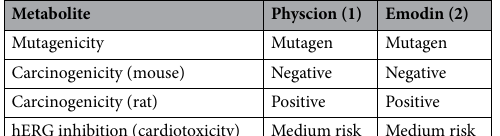
Molecular identification and phylogenetic analysis. All isolated fungal strains were taxonomically characterized by the extraction of their genomic DNA materials followed by PCR amplification and sequenc- ing of the fungal internal transcribed spacer (ITS) region using the universal primers ITS1 and ITS4 14,15 . The Blast tool in National Center for Biotechnology Information (NCBI) was used to compare the good quality sequences to the GenBank database to identify the closest related species with highly similar sequences to the amplified ones. Finally, the multiple sequence alignment and phylogenetic analysis were accomplished using MEGA7 software 22 . Fermentation and preparation of extracts. The pure isolated fungal endophytes were fermented in 1.5 L malt extract liquid medium by placing 2 × 2 cm segments of fresh growing agar culture using 5 L Erlenmeyer flasks. The flasks were incubated at 20 °C ± 2 under static conditions for four weeks. At the end of fermentation, 300 mL of ethyl acetate was added to each flask to stop fermentation. The fungal mycelia alongside with the